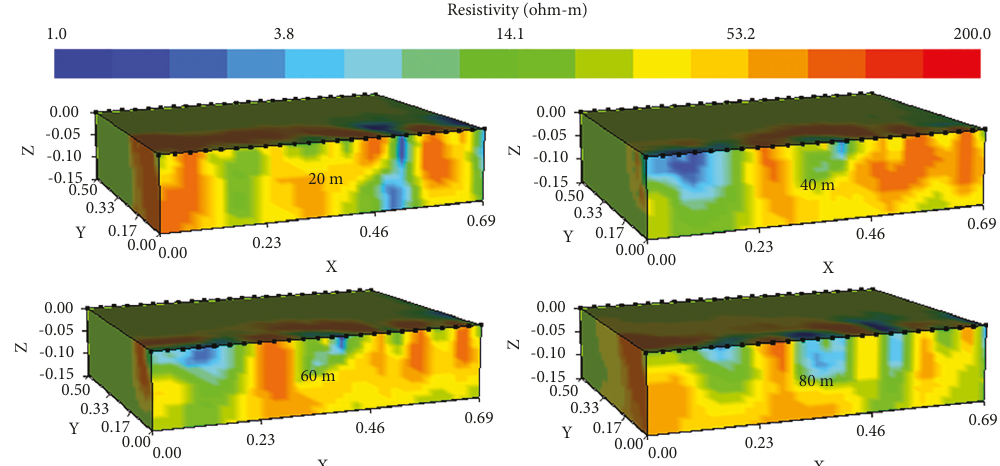
Figure 7: Three-dimensional resistivity inversion map of strata at 15cm above the coal seam.